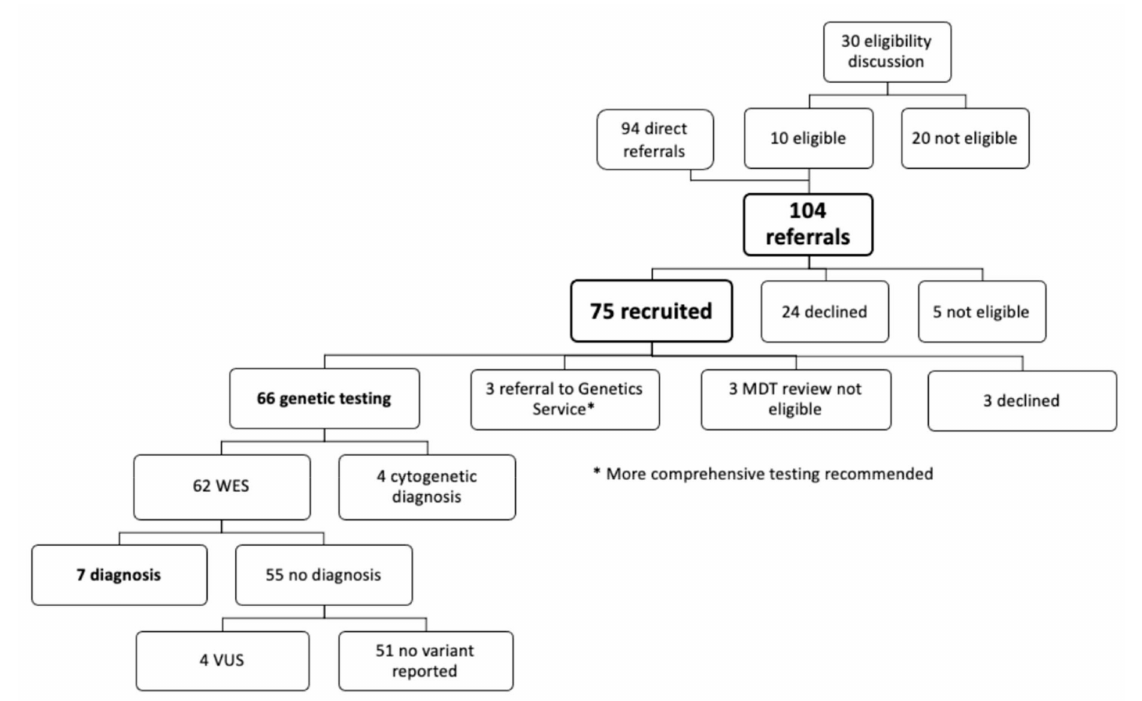
Figure 2. Patient referrals, number recruited, and genomic results. MDT-multi-disciplinary team; WES—whole exome sequencing; VUS-variant of uncertain